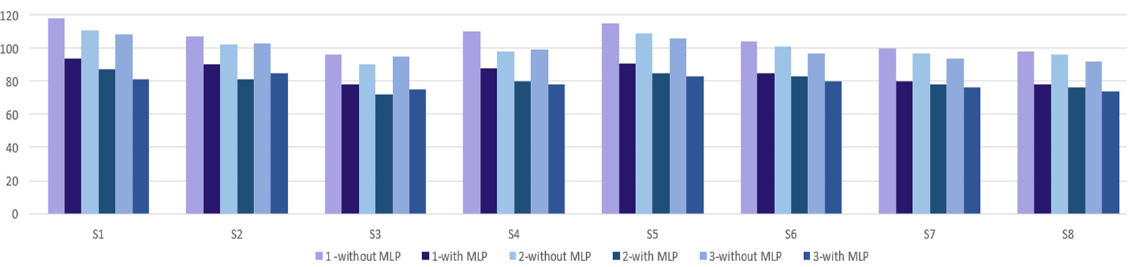
Figure 18. Comparing